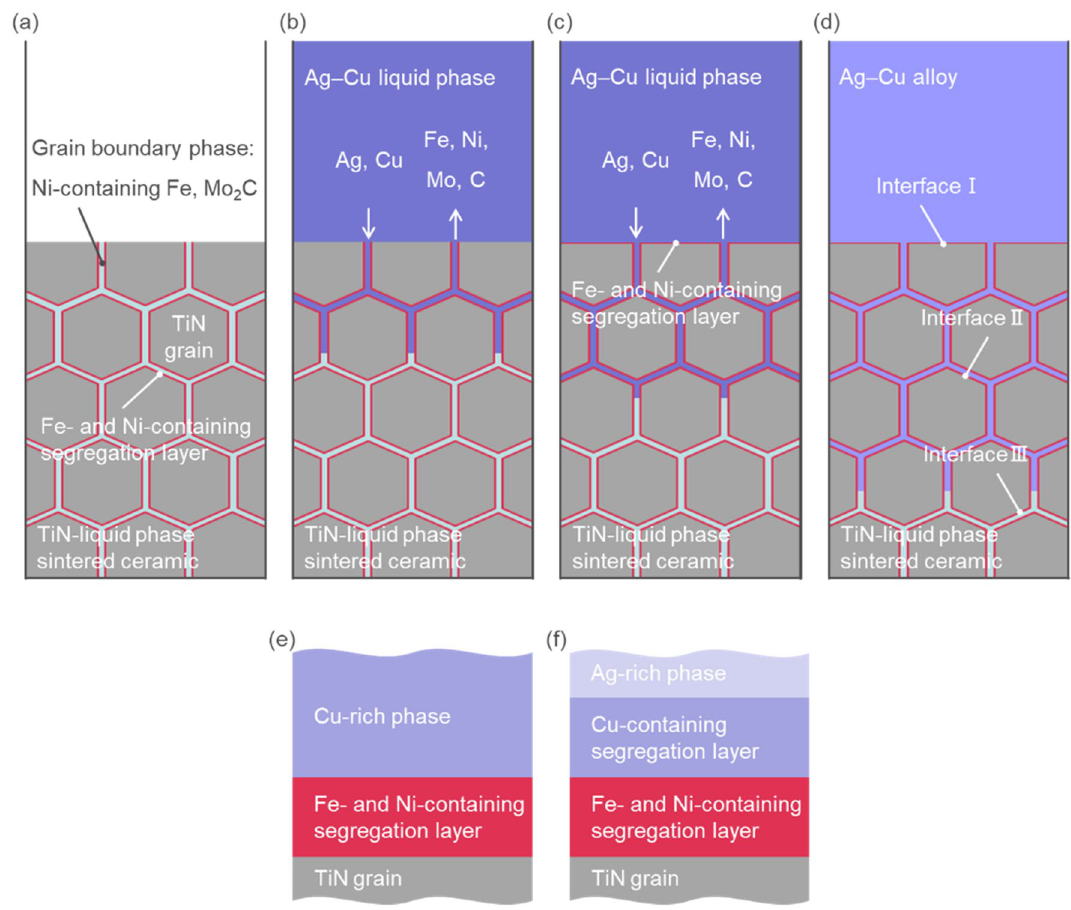
perature. ( d ), e Details of the interfacial structures at ( e ) the Cu-rich phase/TiN grain interface and f the Ag-rich phase/TiN grain inter- face for Interface I and Interface II after